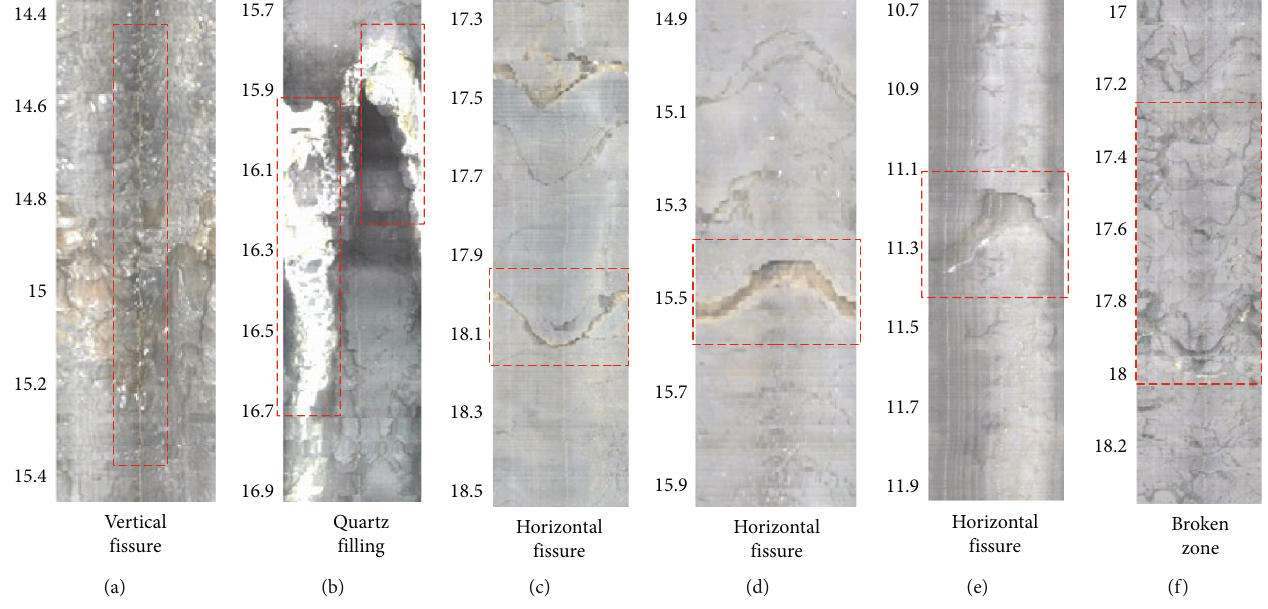
Figure 16: Typical structures in some test holes before